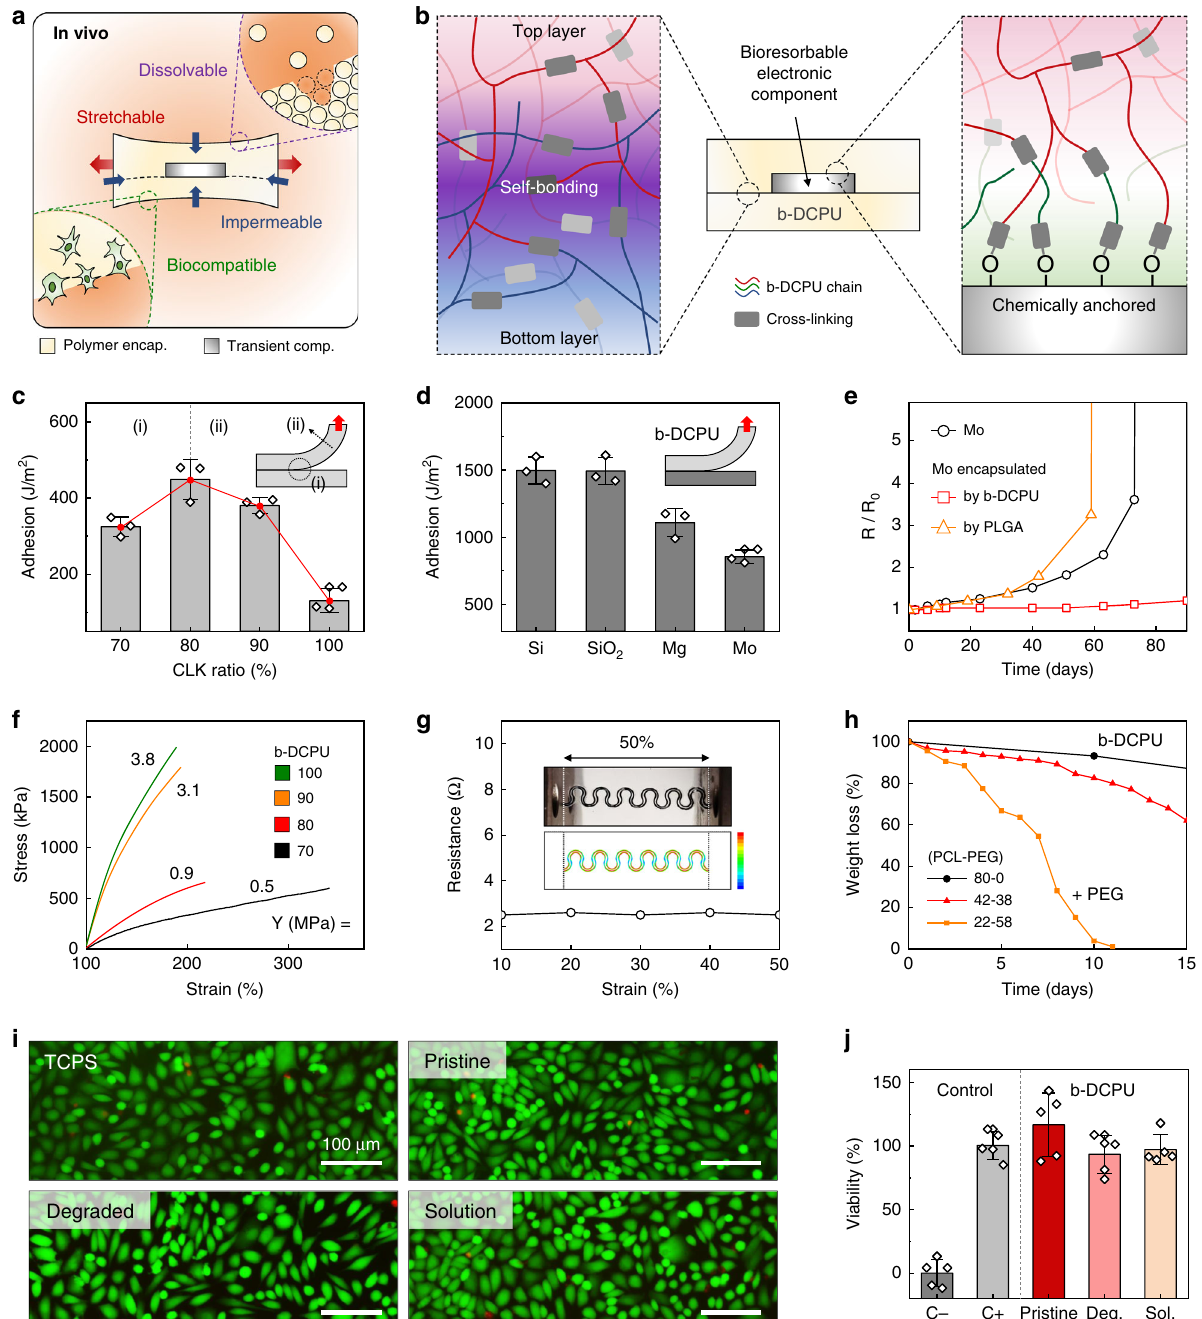
2 V for a fi xed transmission voltage of 16.6 V pp . At distances